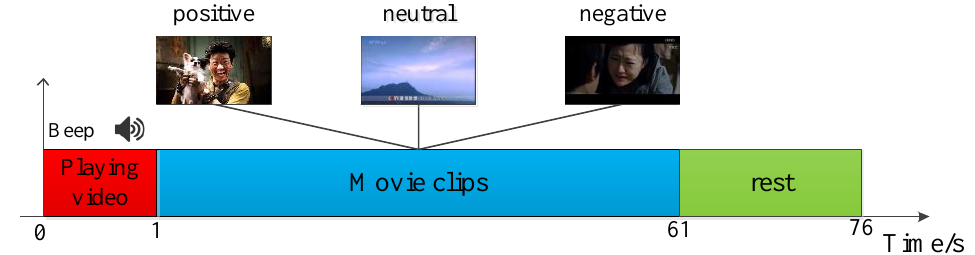
Figure 4. The experimental paradigm of each trial. The horizontal axis indicates the duration of the experiment.